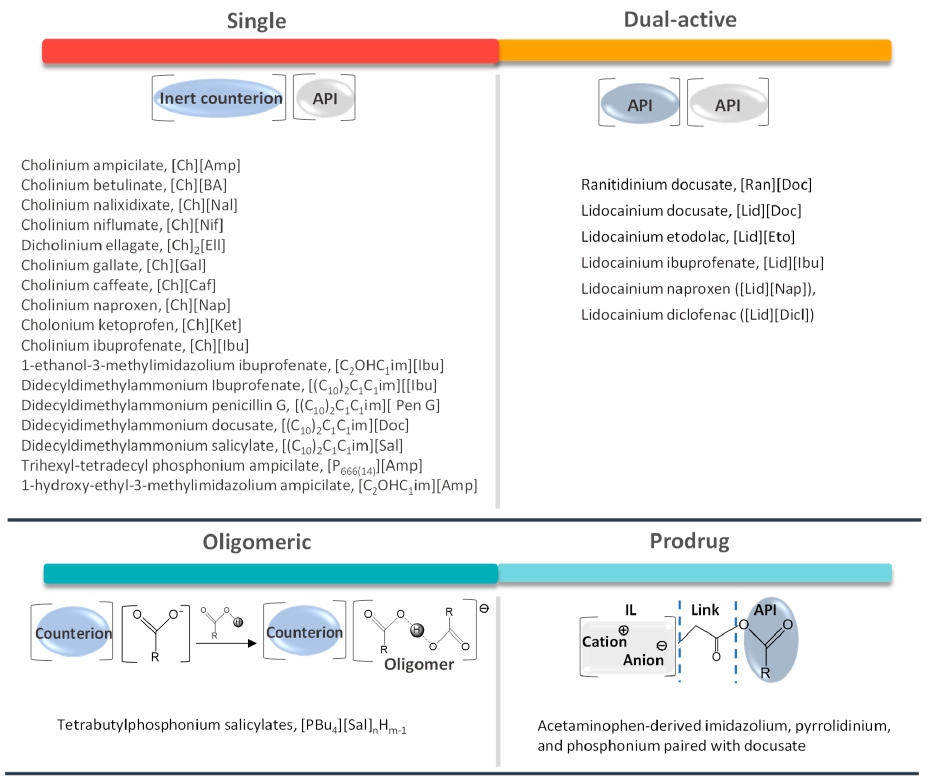
Figure 10. Schematic examples of API-ILs pharmaceutical formulations (adequate references are given along the current section).